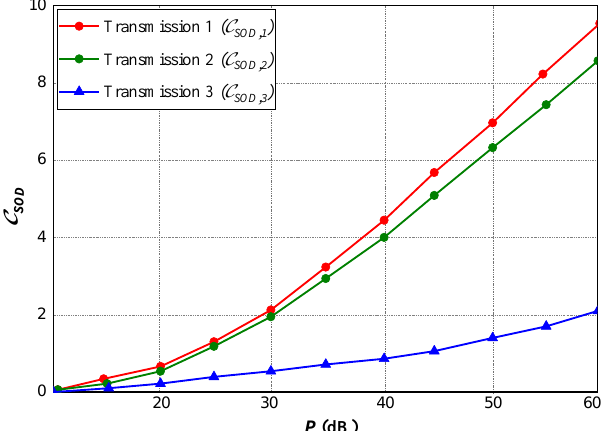
= 0.8 C ) transmission under SOD ,1 SOD